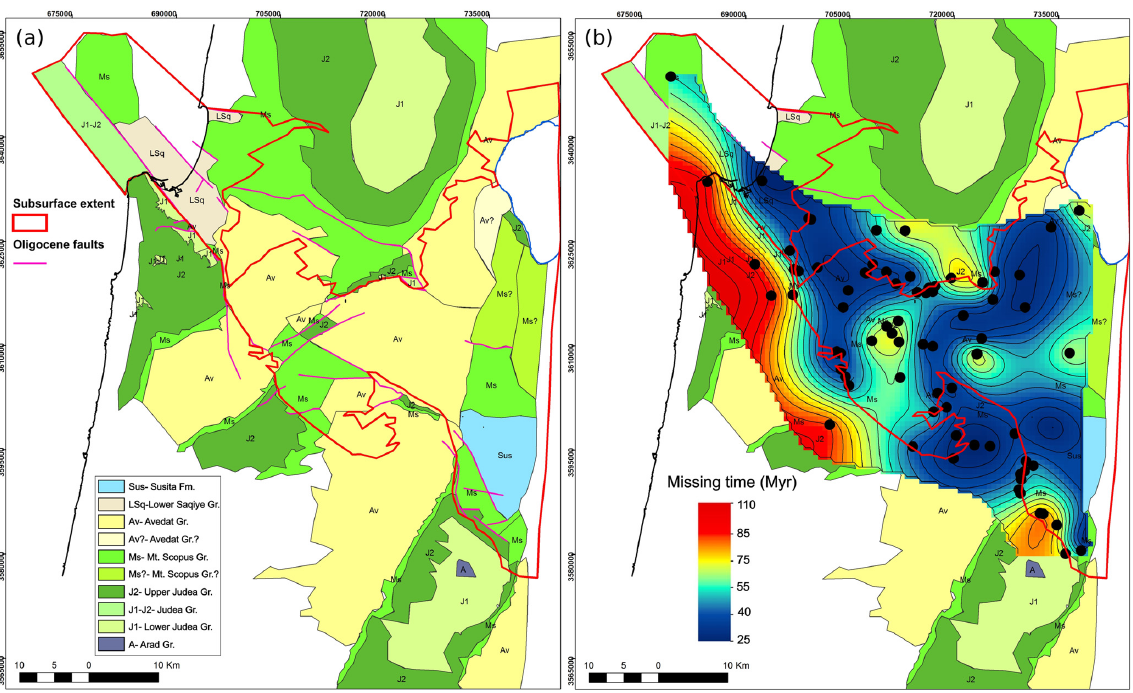
Figure 4. (a) Subcrop map of the Oligocene regional truncation surface (RTS) in the UTM GWS1984 Zone 36N projection. The map shows the youngest units truncated by the RTS based on the integrated interpretation of geological and geophysical data from the surface and subsurface. Colors correspond to the seismic profiles. Red polygon marks the extent of data gathered in the current study. (b) Spatial variation in truncation across the Galilee is a product of kriging interpolation, further represented by contours of equal time gap in million years. Black dots mark locations where the youngest unit below RTS and older unit from above are available for quantifying the time gap (the time gap is discussed in Wald et al., 2019). Some of the data points are today exposed above the datum of the map. Note that some of the points may include pre-Oligocene